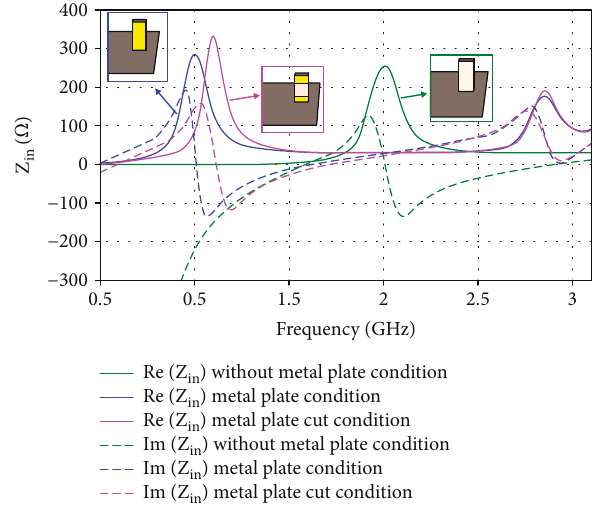
Figure 5: Input impedances for di ff erent DRA boundary conditions.